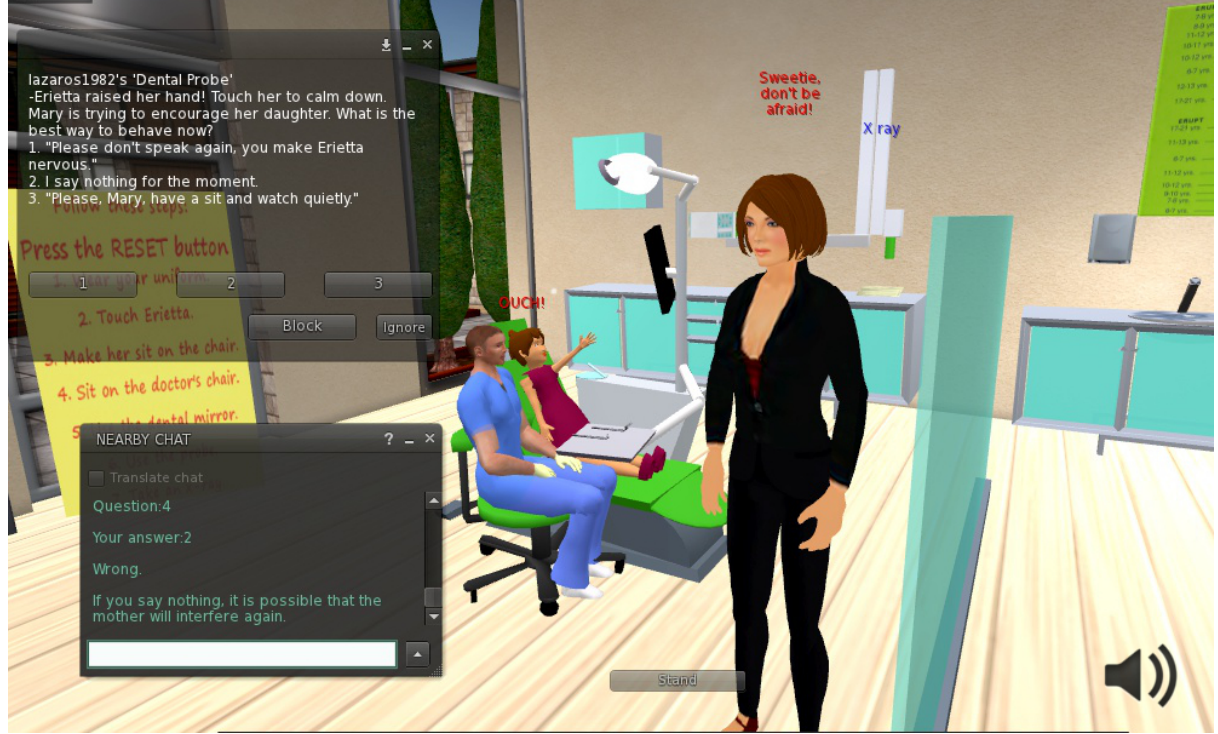
Figure 2. Erietta raises her hand, while her mother interferes, showing text and speech